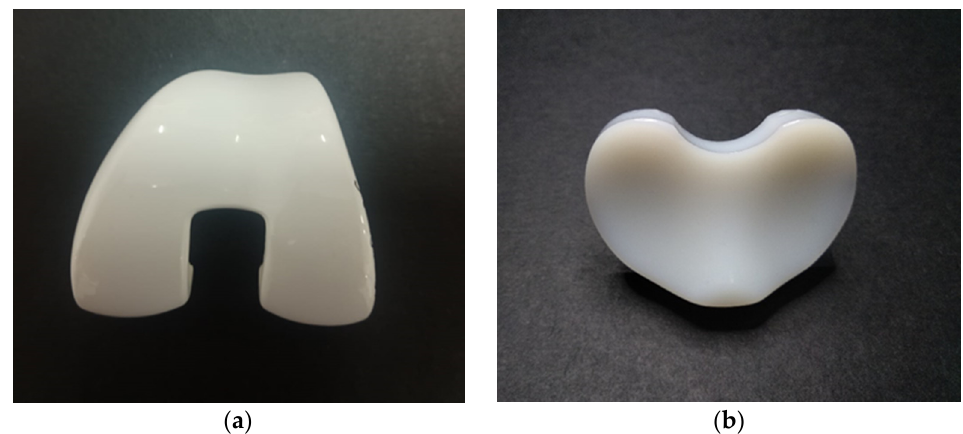
Figure 1. Zirconia Toughened Alumina (ZTA) femoral component ( a ) and UHMWPE tibial meniscus ( b ) before test .